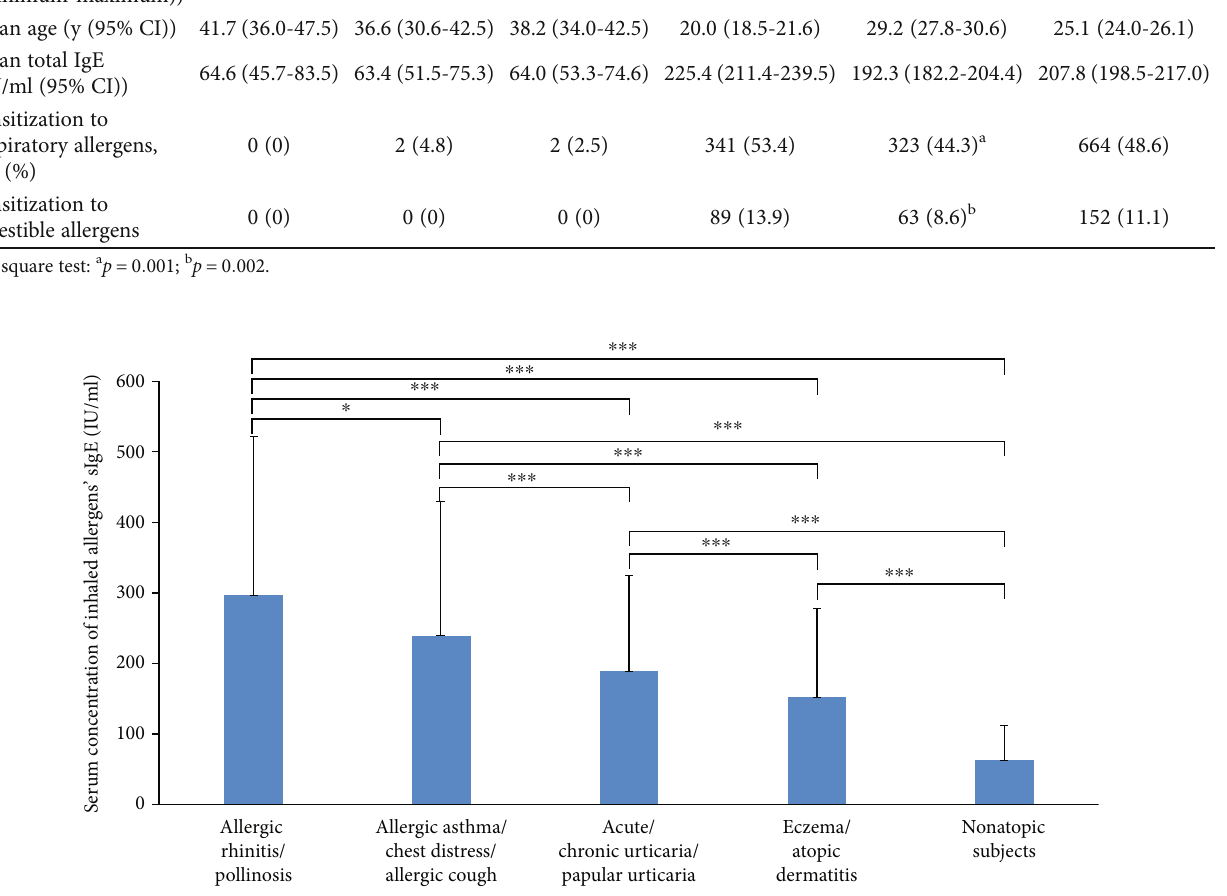
Figure 1: Mean value of total IgE in di ff erent diseases ( ∗∗ p = 0 : 024 , ∗∗∗ p < 0 : 001 ). Table 3: Number of allergen-positive patients with the relevant allergic